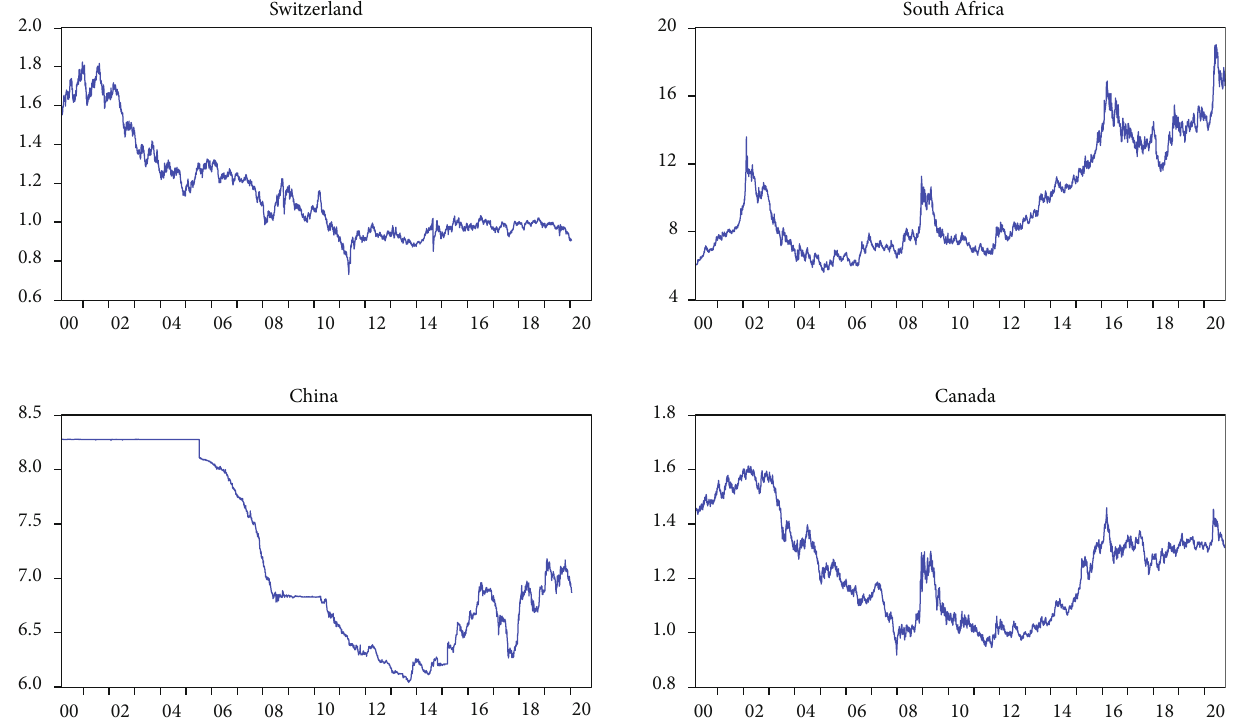
Figure 2: Time series plots of exchange rates by country. Source: FRED, 2000-2020.